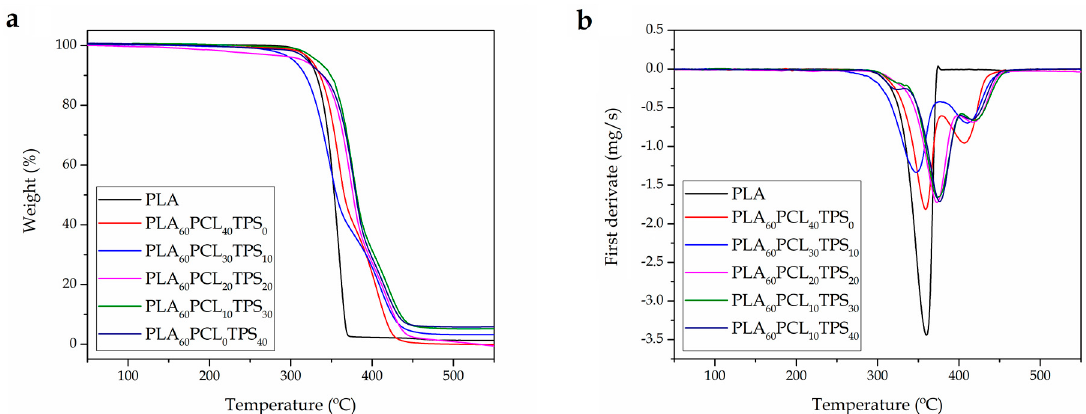
Figure 6. Comparative plot of the polylactide (PLA), poly( ε -caprolactone) (PCL), and thermoplastic starch (TPS) blend pieces in terms of: ( a ) Thermogravimetric analysis (TGA) curves; and ( b ) first derivative thermogravimetric (DTG) curves. Table 4. Thermal degradation properties in terms of the onset degradation temperature (T 5% ), degradation temperature (T deg ), and residual mass at 650 °C of the polylactide (PLA), poly( ε -caprolactone) (PCL), and thermoplastic starch (TPS) blend pieces. Sample T 5% (°C) T deg (°C)